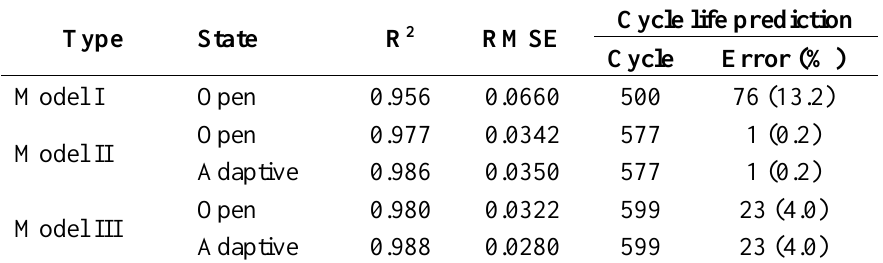
Table 2. Predicted battery D’s cycle life from the three